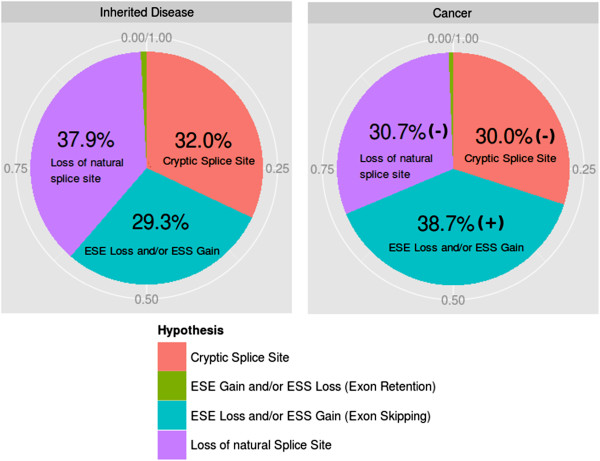
Confident hypotheses of the underlying splicing mechanism disrupted for predicted exonic SAVs in Inherited disease and somatic variants in Cancer. Significant enrichment (+) or depletion (-) for a specific hypothesis is shown for the Cancer versus Inherited disease datasets (Fisher’s exact test with a Bonferroni-corrected threshold of P < 0.05).